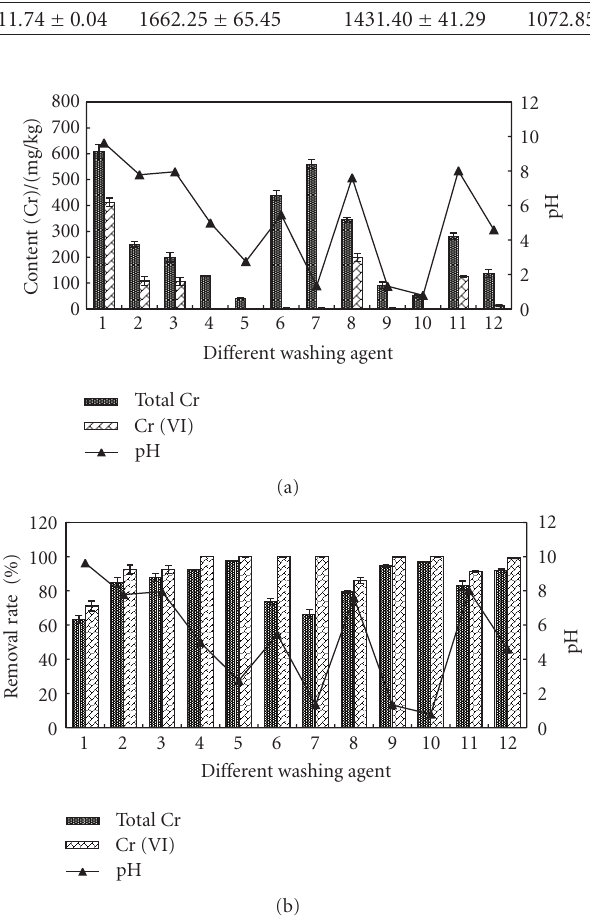
Figure 4: Comparison of total Cr, Cr (VI), and pH in solid sample after being washed by di ff erent agents. Washing agent: 1—water; 2—0.05 mol/L EDTA-Na 2 ; 3—0.1 mol/L EDTA-Na 2 ; 4—0.1 mol/L citric acid; 5—0.5 mol/L citric acid; 6—0.1 mol/L oxalic acid; 7— 0.5mol/L oxalic acid; 8—0.1 mol/L HCl; 9—0.5 mol/L HCl; 10— 1mol/L HCl; 11—0.1 mol/L acetic acid; 12—0.5 mol/L acetic acid.